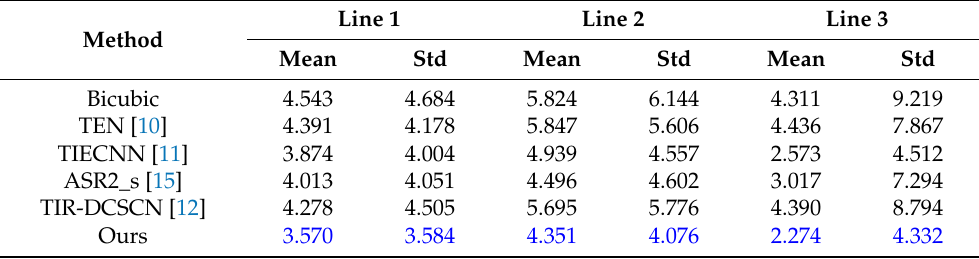
Table 6. Evaluation of the mean and standard deviation of the difference between the ground truth and enhanced results in the line profiles (blue-colored: the best